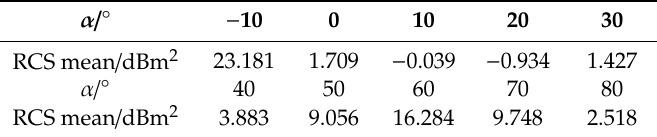
Table 4. Influence of azimuth on radar cross-section (RCS) mean of m fan , N obs,fan = 1, β = 0 ◦ .